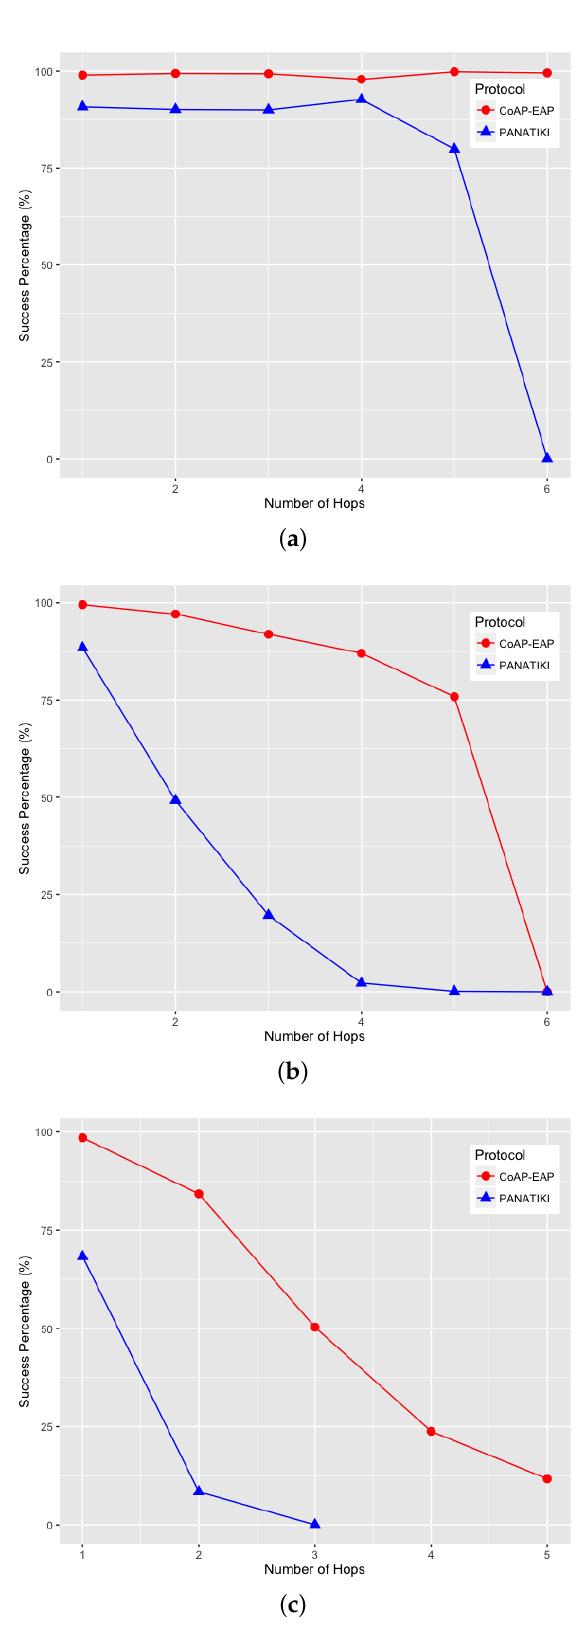
Figure 10. Bootstrapping success percentage. ( a ) Success percentage with 0.0 loss ratio; ( b ) Success percentage with 0.1 loss ratio; ( c ) Success percentage with 0.2 loss